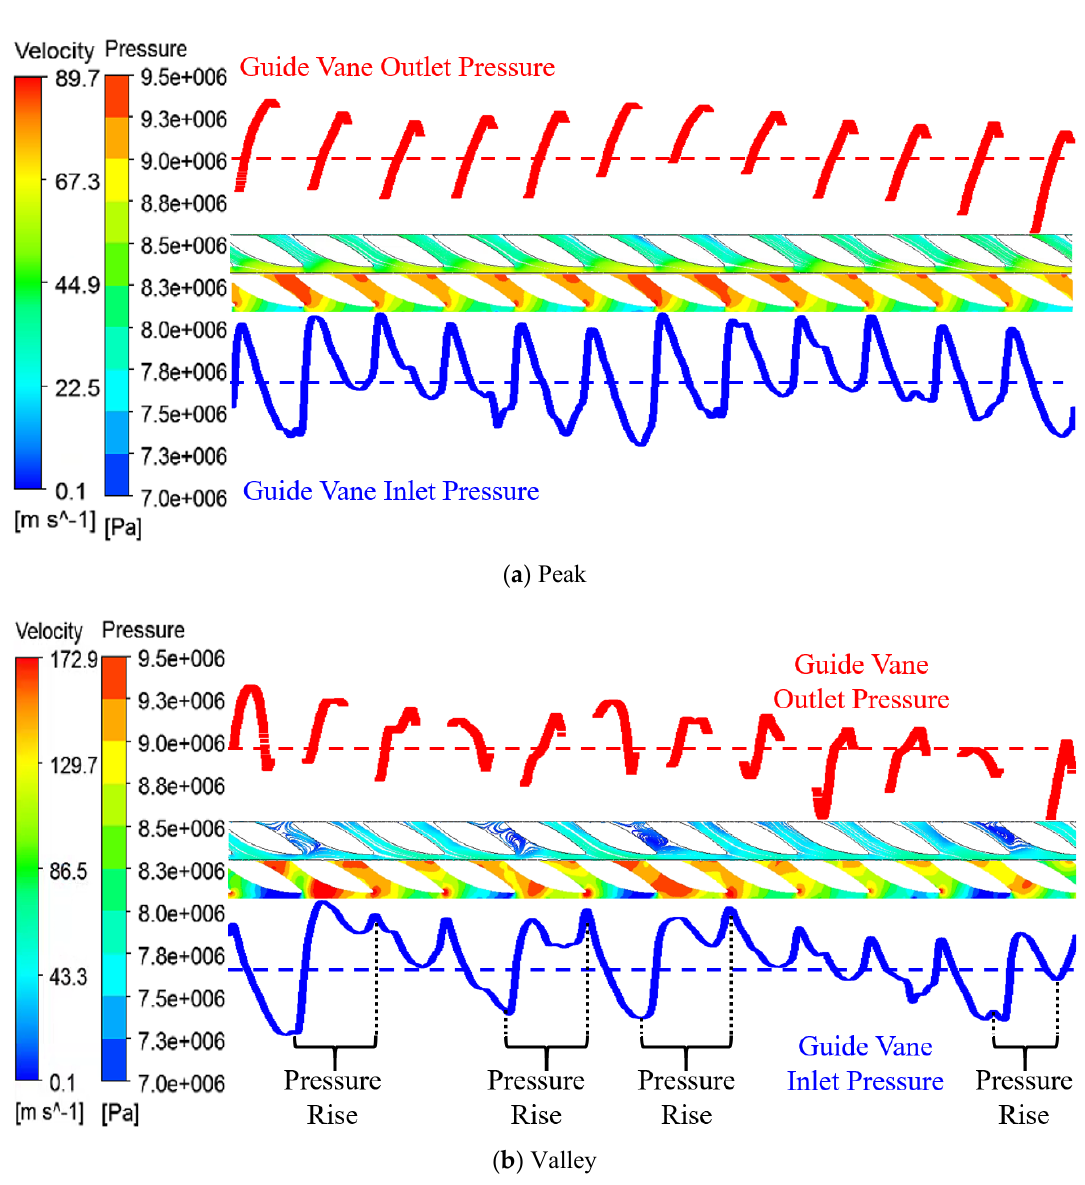
Figure 9. Blocking and pressurization effect of stall in the diffuser.